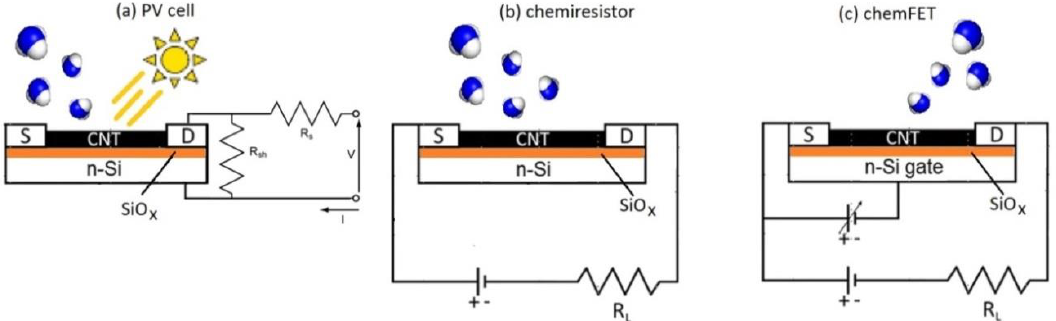
Figure 1. Layout of the read-out setup in a photovoltaic (PV) cell ( a ), chemiresistor ( b ) and chemical field-effect transistor (chem-FET) configurations ( c ). The n-doped silicon (Si) layer in ( c ) acts as the gate in the chem-FET, while it represents the n-side of the junction in ( a ). The p-side of the junction in ( a ) is represented by the carbon nanotube (CNT) layer. In all schemes, the SiO x layer between Si and CNT is expressly shown. Contact pads (S and D) can be operated as source and drain in chem-FET ( c ), while they are used as metallic contacts in ( b ) to collect the current induced by gas exposure. In ( a ), these pads are equivalently used as contacts for the p-type layer of the junction. R S , R sh , and R L are defined as the series, shunt, and load resistance, respectively.